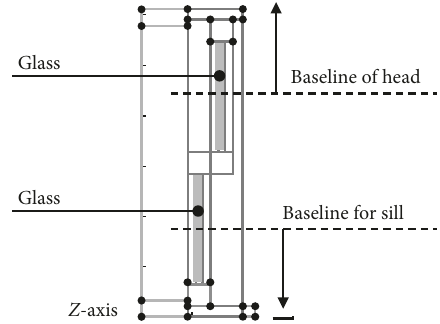
Figure 4: Cross-section generation algorithm (head and